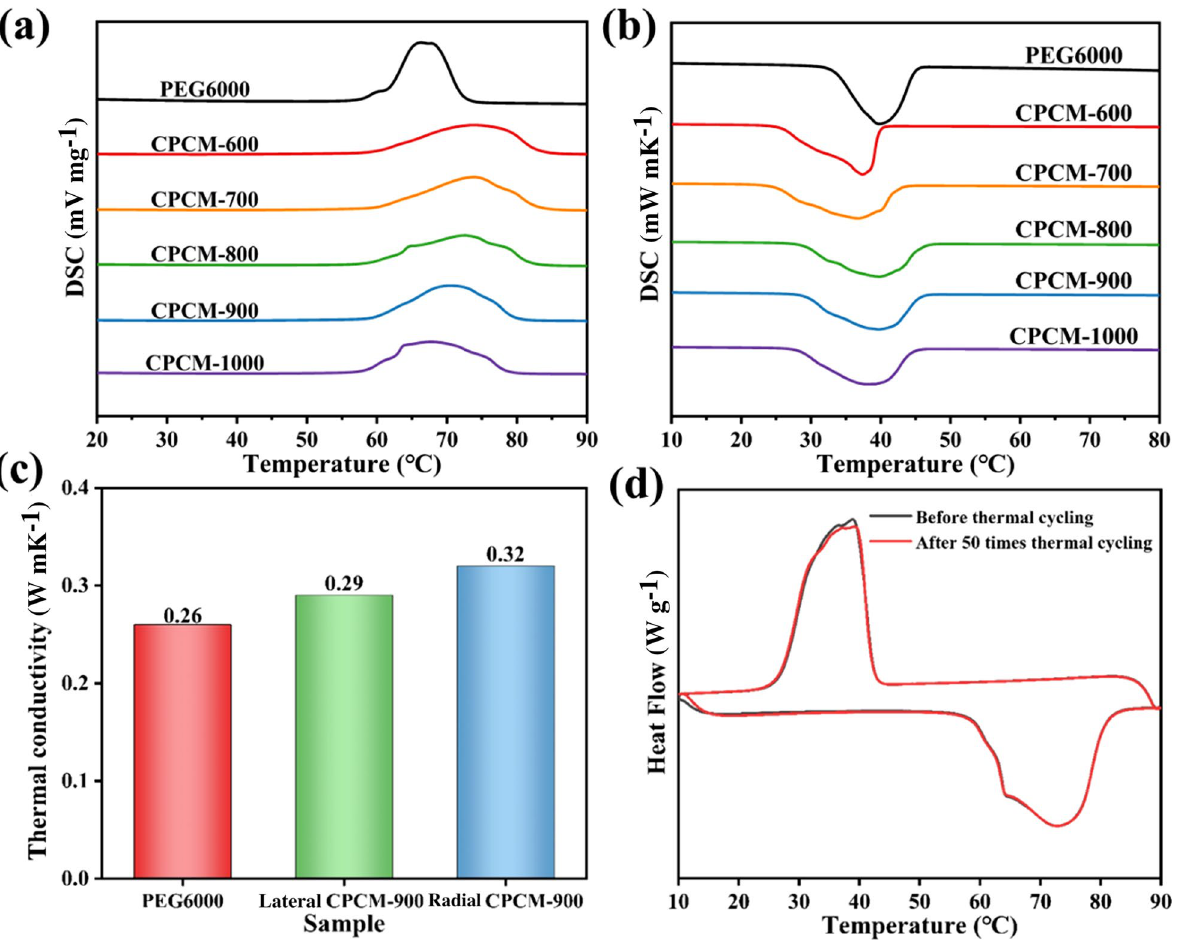
Fig. 9 DSC curves of PEG6000, CPCM-600, CPCM-700, CPCM-800, CPCM-900, CPCM-1000 during heating ( a ) and cooling ( b ); ( c ) Ther- mal conductivity of the samples; ( d ) DSC curves before and after 50 cycles of CPCM-900